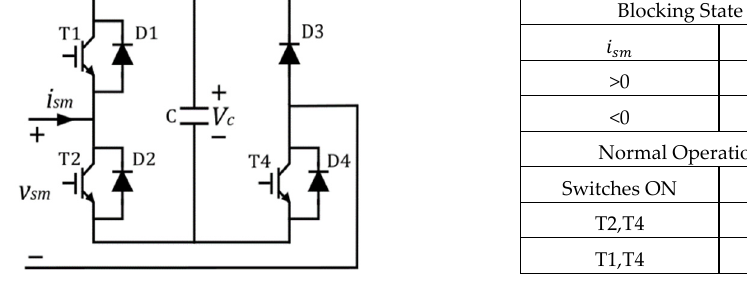
Figure 7. UFBSM. Figure 7.